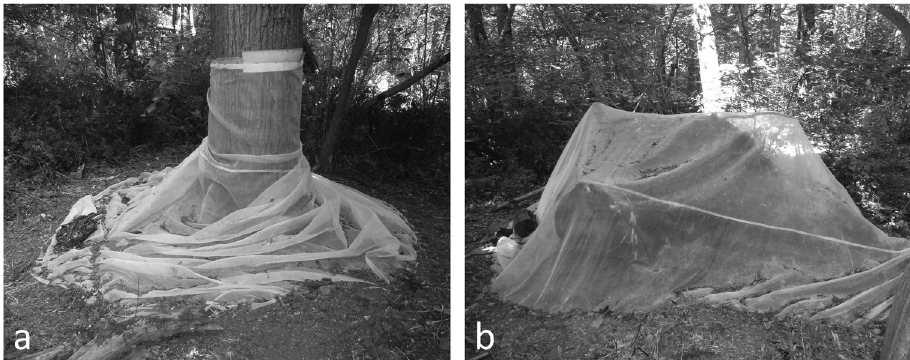
Figure 2. Emergence traps placed on larval development sites (DS) detected in 2014 by means of radio- telemetry. A Emergence trap on Quercus sp. SDT (DS01) B Emergence trap on Quercus rubra Uprooted stump